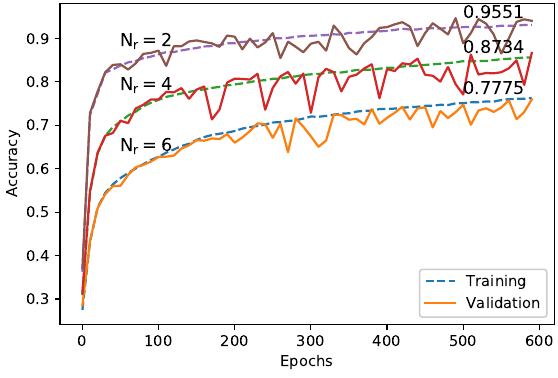
Figure 4. Performance converenge versus